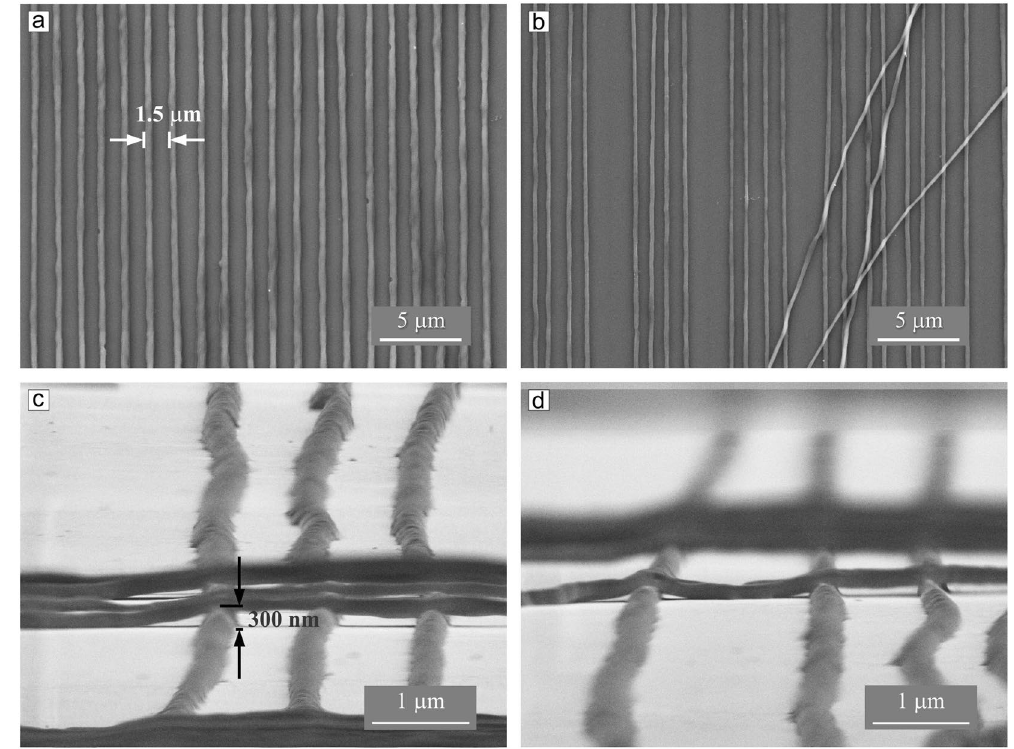
Figure 4. SEM micrographs of the nano-wires: ( a ) an array of 20 nano-wires perfectly aligned; ( b ) several nano-wires displaced from their initial positions by capillary forces during solvent exposure. ( c and d ) Side-view SEM images show clearly that the nano-wires are free standing separate entities adsorbed on a silicon